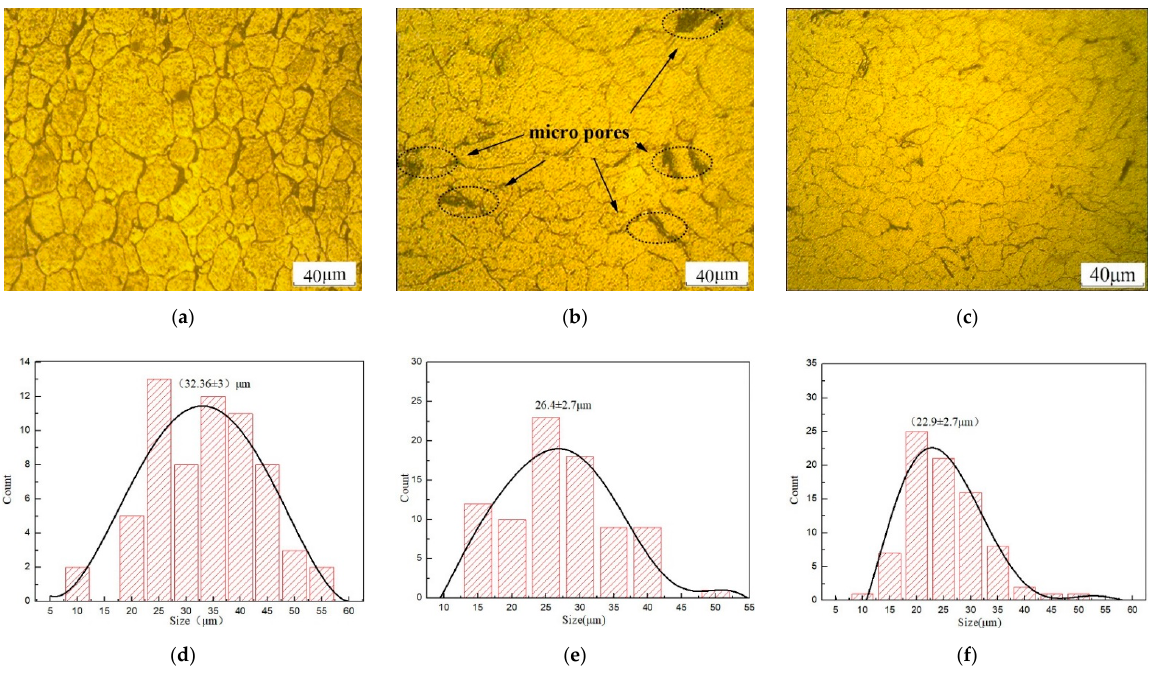
Figure 5. Microstructures and the grain sizes distribution of the matrix and 2024Al with different reinforcement: ( a , d ) the matrix; ( b , e ) GNPs/2024Al composites; ( c , f ) CeO 2 -GNPs/2024Al composites.